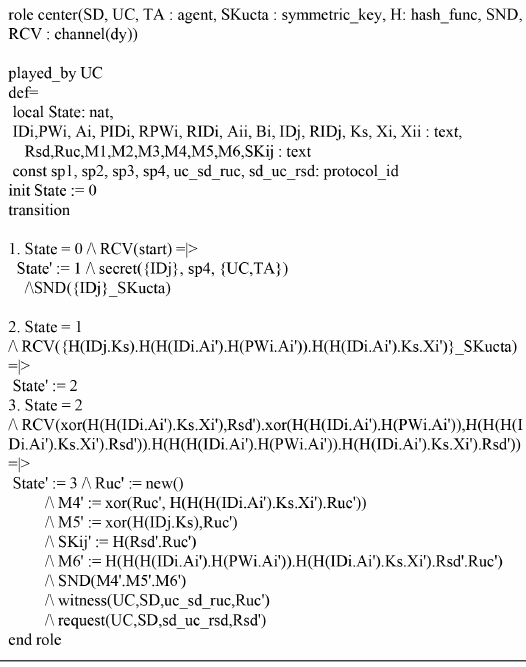
Figure 11. Role specification of utility